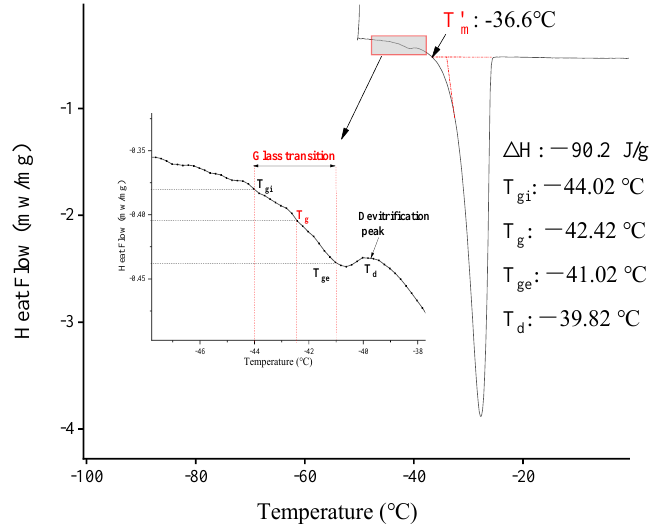
Figure 1. DSC thermogram of chestnut kernels containing freezable water (0.43 g water/g wet basis).